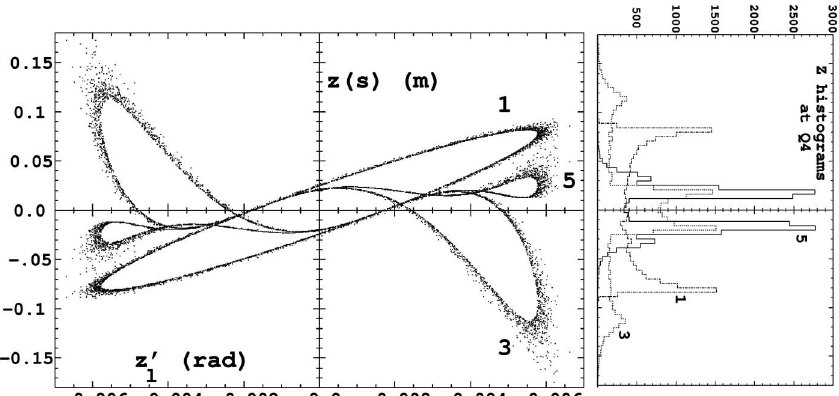
FIG. 6. Distortion of the elliptical phase space invariant and related histograms of the (cid:3) 6 s z , 7 s z (cid:4) region of the transverse beam tails at Q4.